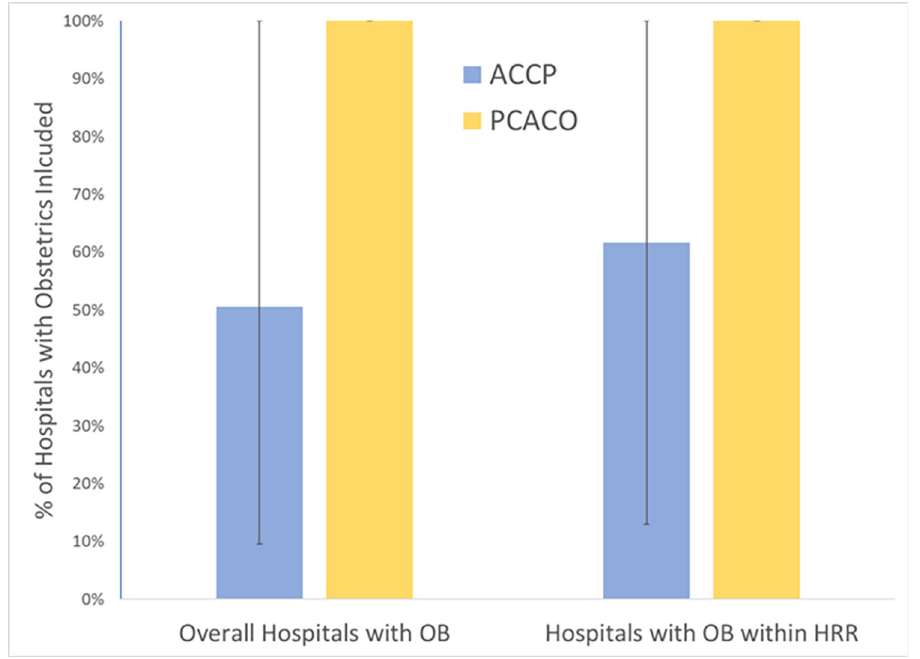
Fig 1. Percent of hospitals with obstetrics departments included within Medicaid ACOs, by ACO type. Notes: Vertical bars represent minimum and maximum values for ACOs within that category.